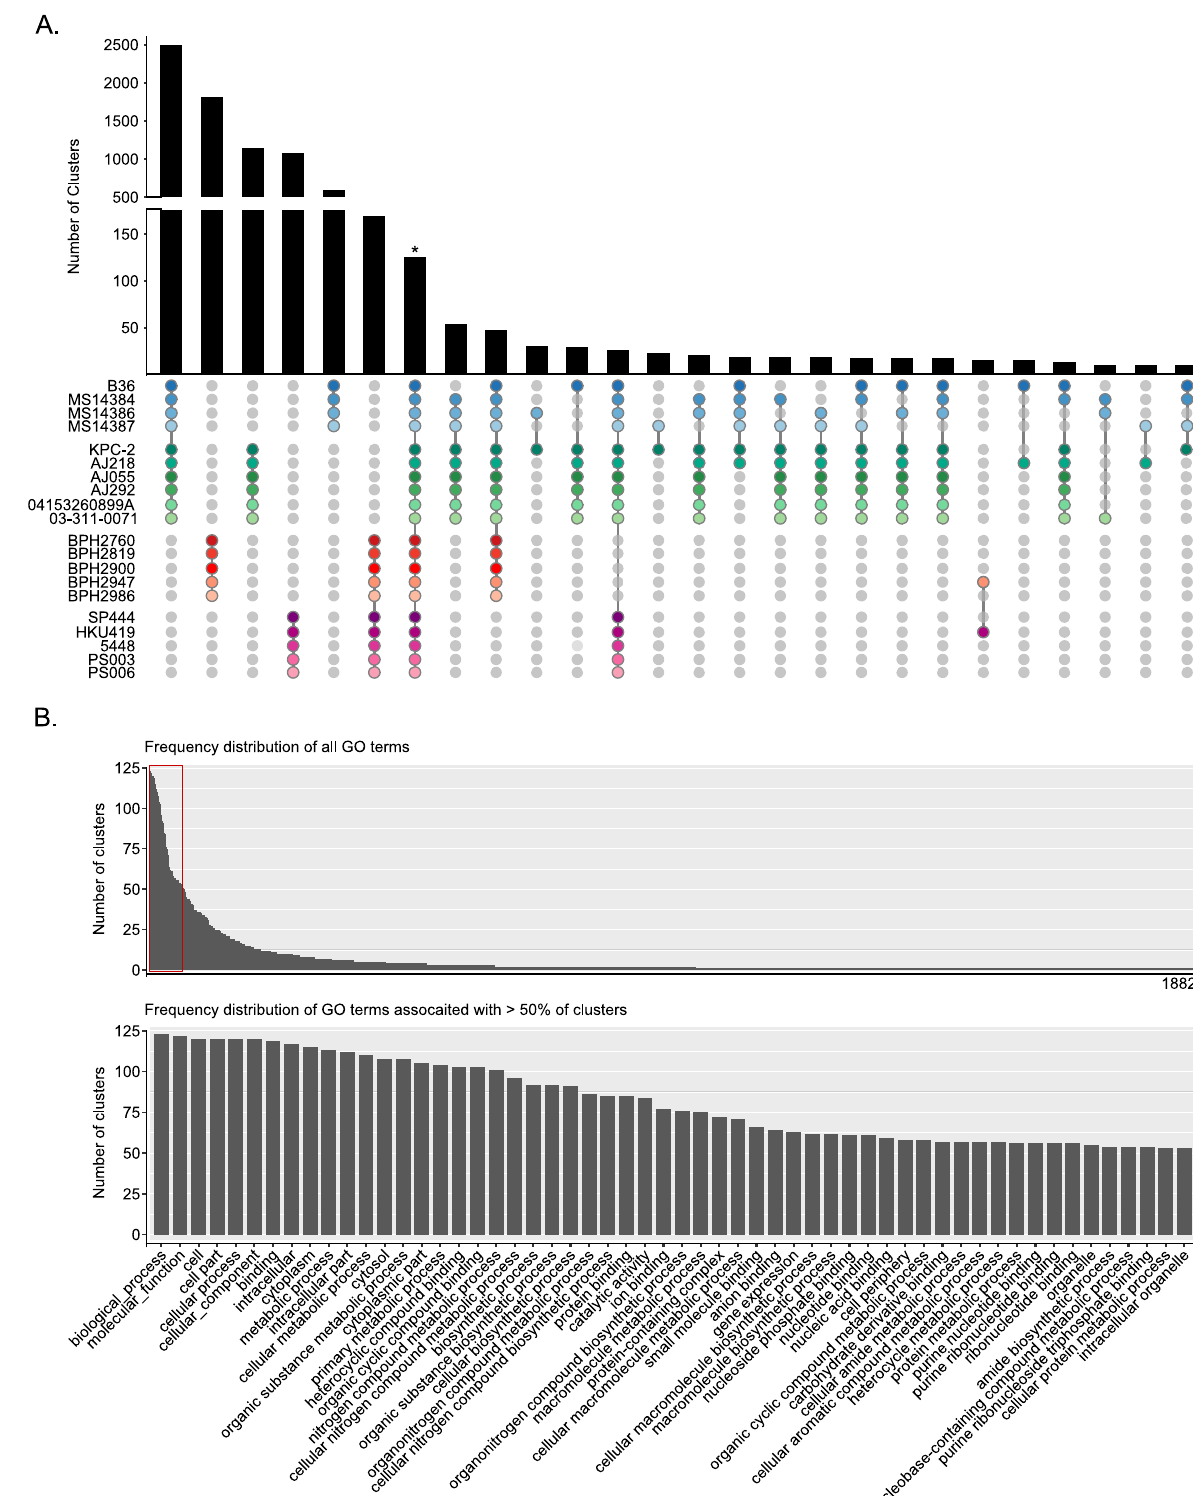
Fig. 3 | Conserved protein orthologues amongst genomes and associated functional analysis. A comparison of protein orthologue clusters across the 20 genomes investigated is illustrated. A The sharing of orthologue clusters across species(invariouscombinations)orthoseconserved withinaspeciesareshownin the UpSet plot, ordered based on the frequency and coloured to match the gen- omes as illustrated in the phylogenetic trees in Fig. 2. Combinations with less than ten shared orthologue clusters are not shown. The asterisk (*) indicates the 125